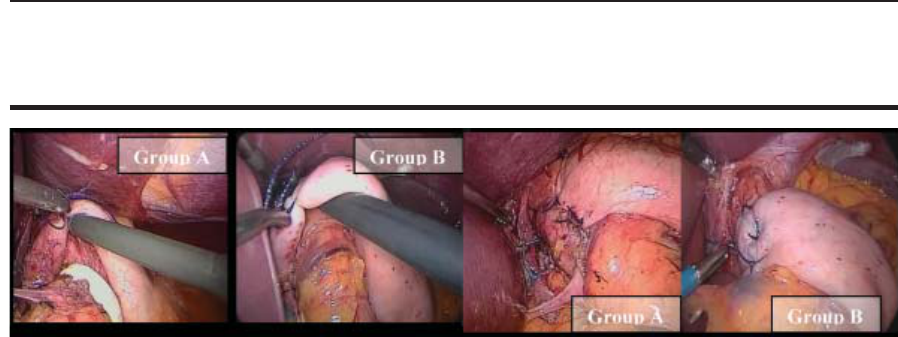
FIGURE 4 - Fundoplication: calibration with 10 mm instrument (A and B) and fi nal appearance (C and